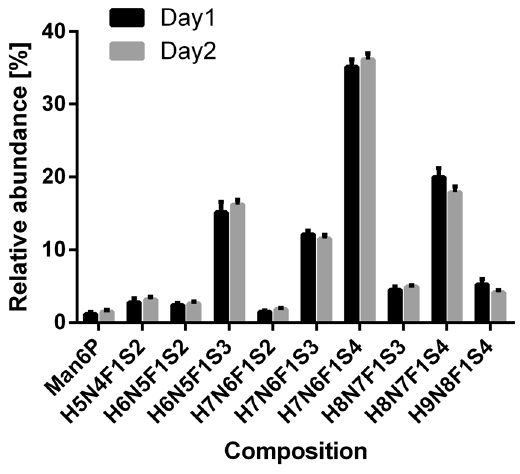
Figure 6. Repeatability and intermediate precision of the MALDI-TOF-MS profiling method. Relative abundances of the 9 most abundant EPO glycans and Man6P were measured in sextuplicate on two different days. Major glycans showed a CV ≤ 6% and there were no significant differences between the profiles of both days.